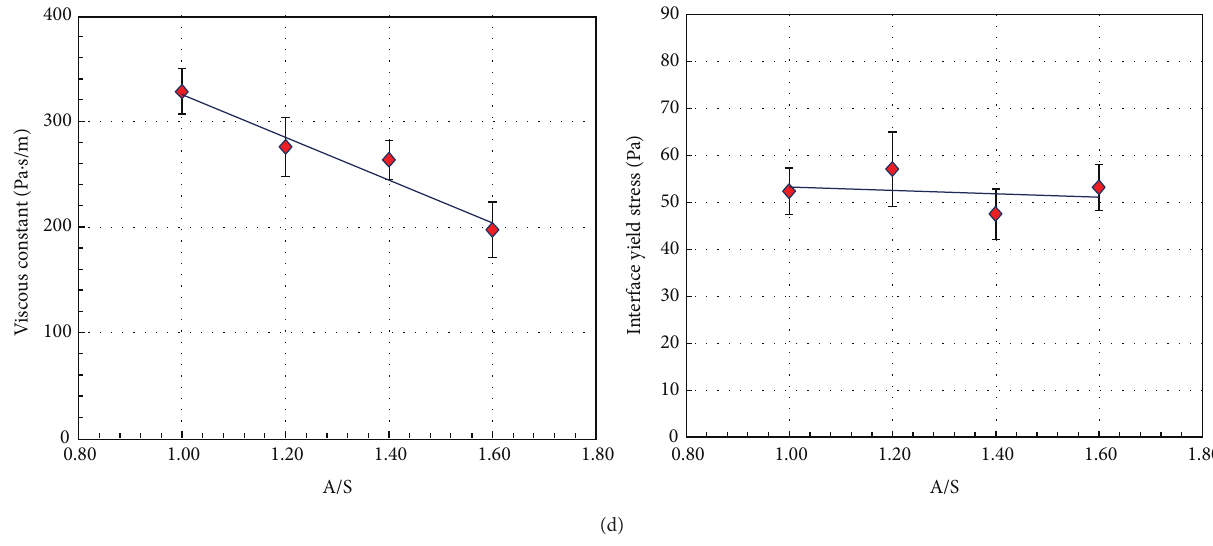
Figure 7: Experimental results of the first test program: (a) influence of the cement paste volume; (b) influence of the aggregates size; (c) influence of water/cement ratio; and (d) influence of aggregates/sand